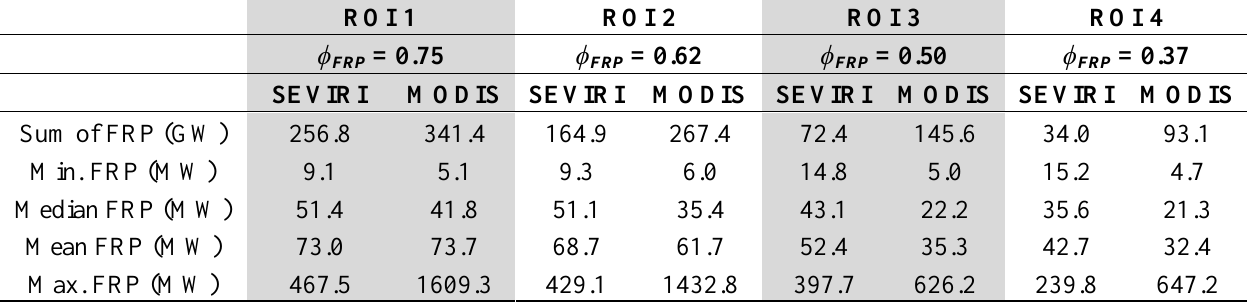
Table 1. Summary of concurrent SEVIRI and MODIS active fire pixels detected in each region of interest (ROI) shown in Figure 1a between 1 October 2008 and 30 April 2009 using, respectively the SEVIRI FTA algorithm [34] and the MODIS active fire detection algorithm [38]. According to Equation (1), ϕ i ndicates the ratio of the seasonal sum FRP of FRP measured by SEVIRI to that concurrently measured by MODIS.